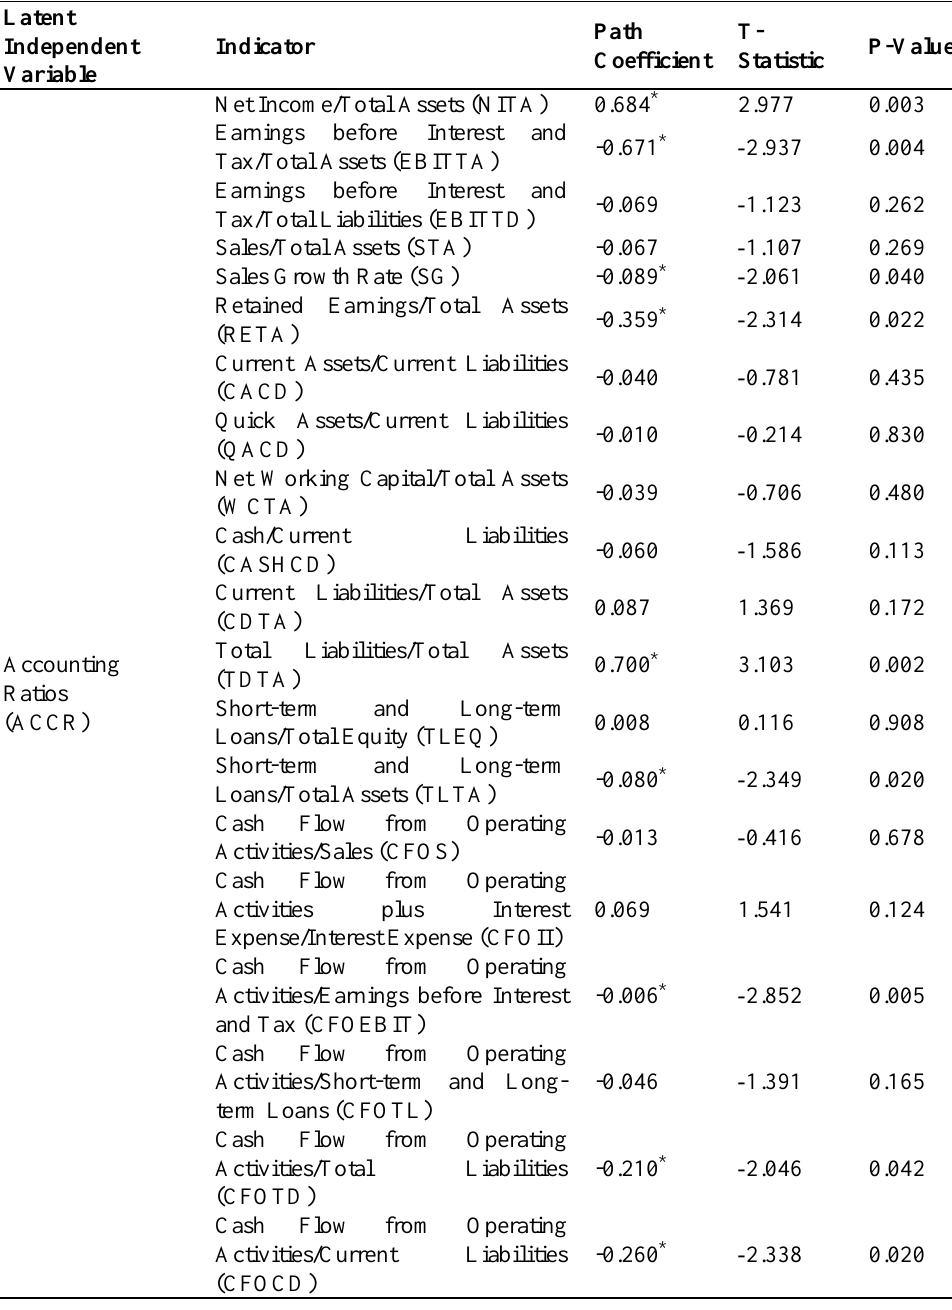
Table (7). Path Coefficient, T-Statistic and P-Value for Indicators Latent